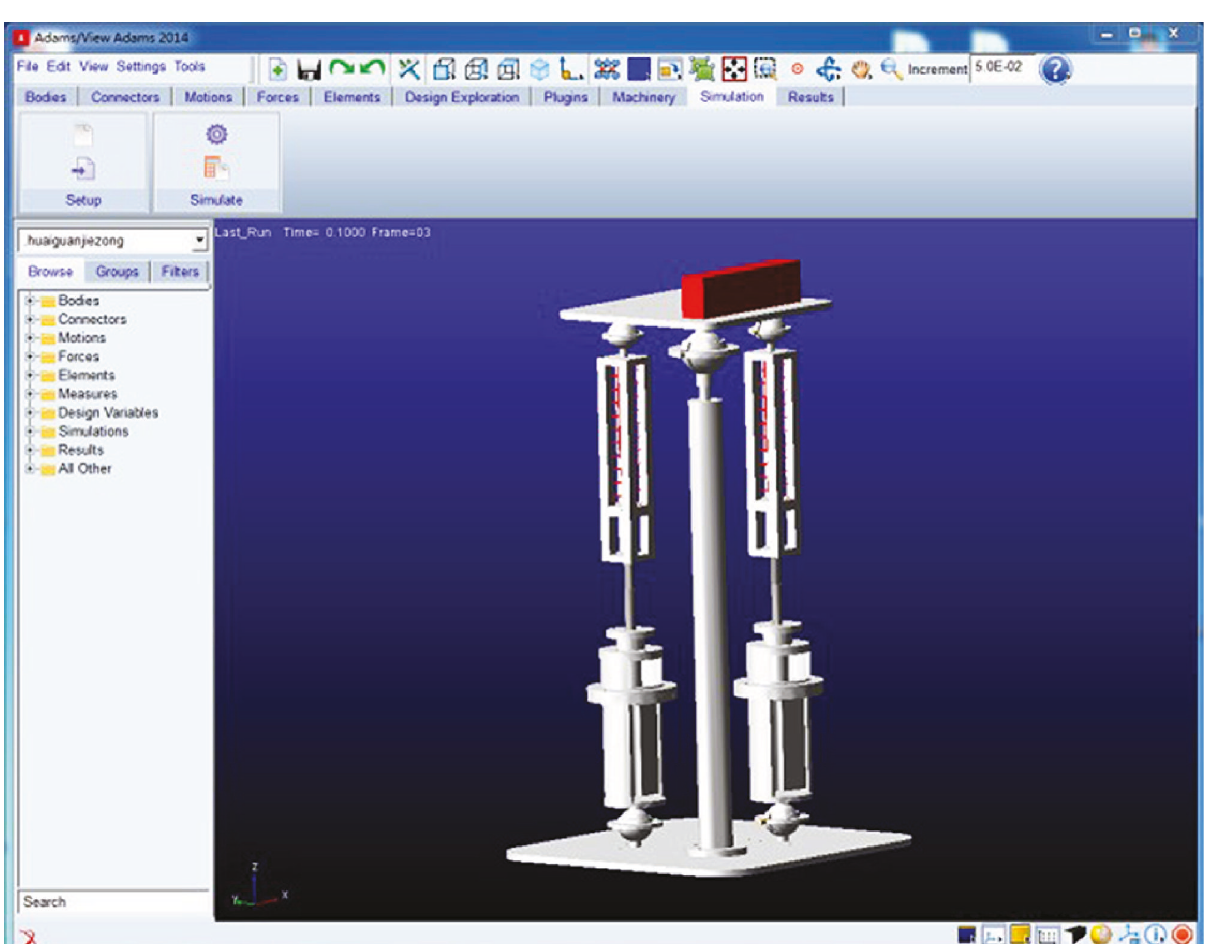
Figure 14: Importing the model into